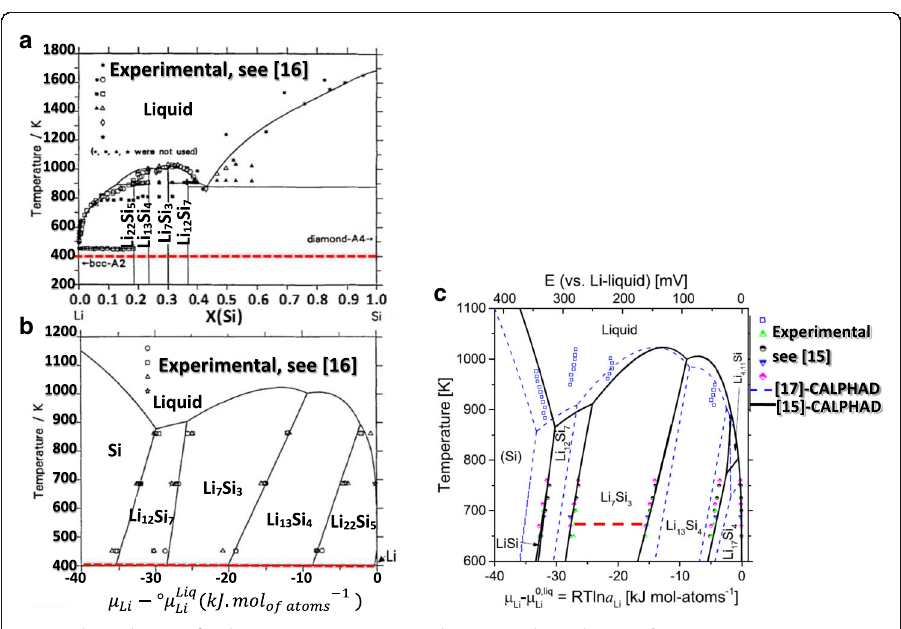
Fig. 7 Phase diagram for the Li-Si system (Braga et al. 1995). a phase diagram; b temperature vs electrochemical potential of the Li vs. Li-liquid (Braga et al. 1995) and c (Liang et al. 2017) (adapted